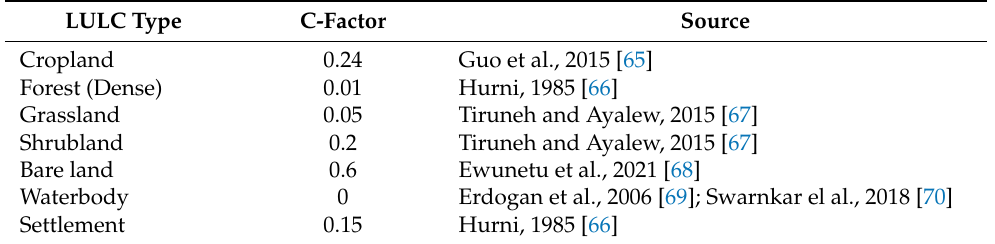
Table 2. C-factor value of different soil types.